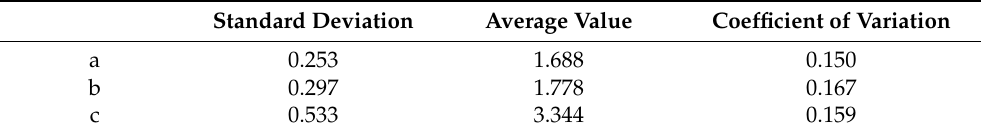
Table 7. The variability uniformity experiment of ten different feeding